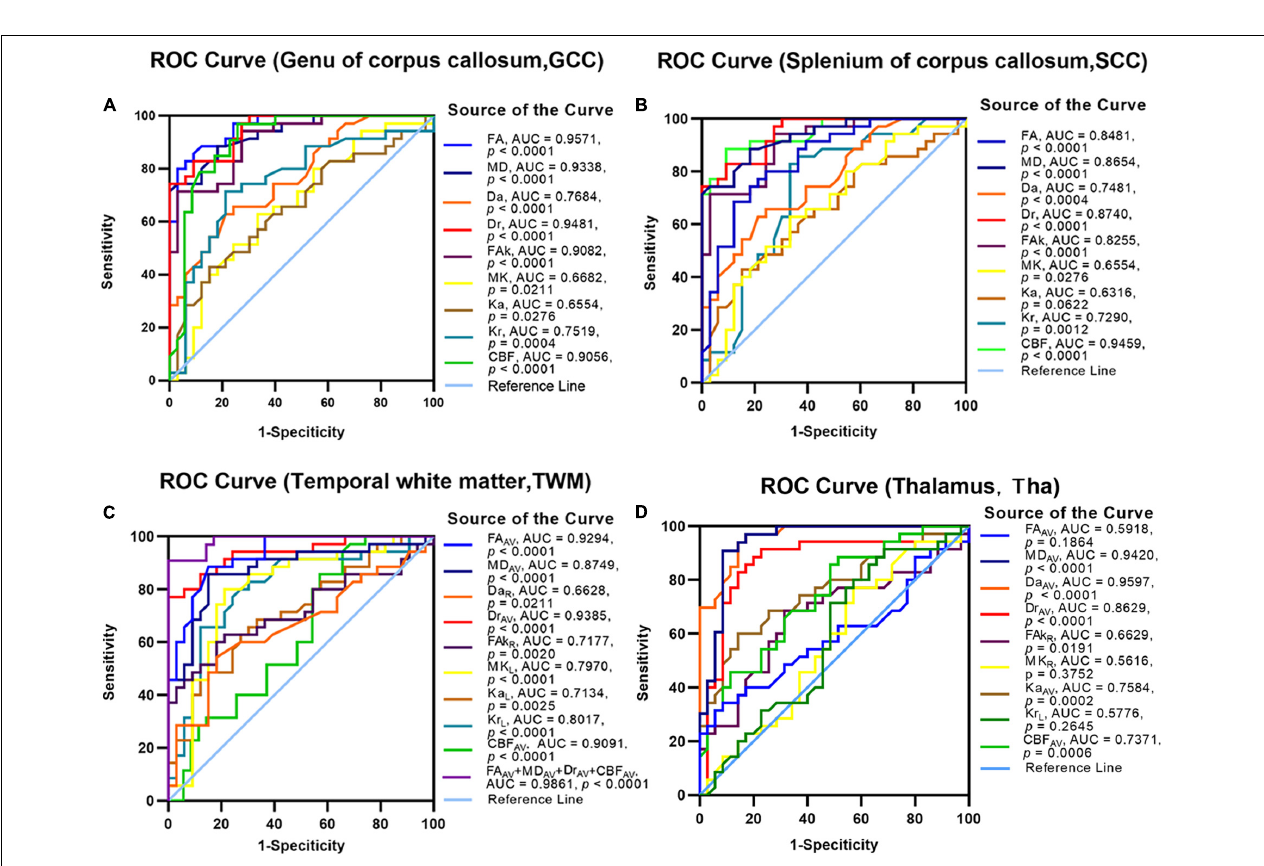
FIGURE 4 | The receiver operating characteristic (ROC) analysis to assess the efficacy of DKI/ASL-derived parameters for discriminating patients with BD from healthy controls. The discriminative efficacy of DKI-derived parameters and CBF values of the genu of the corpus callosum (A) , splenium of the corpus callosum (B) , temporal white matter (C) , and thalamus (D) were assessed for distinguishing the patients with BD from healthy controls.